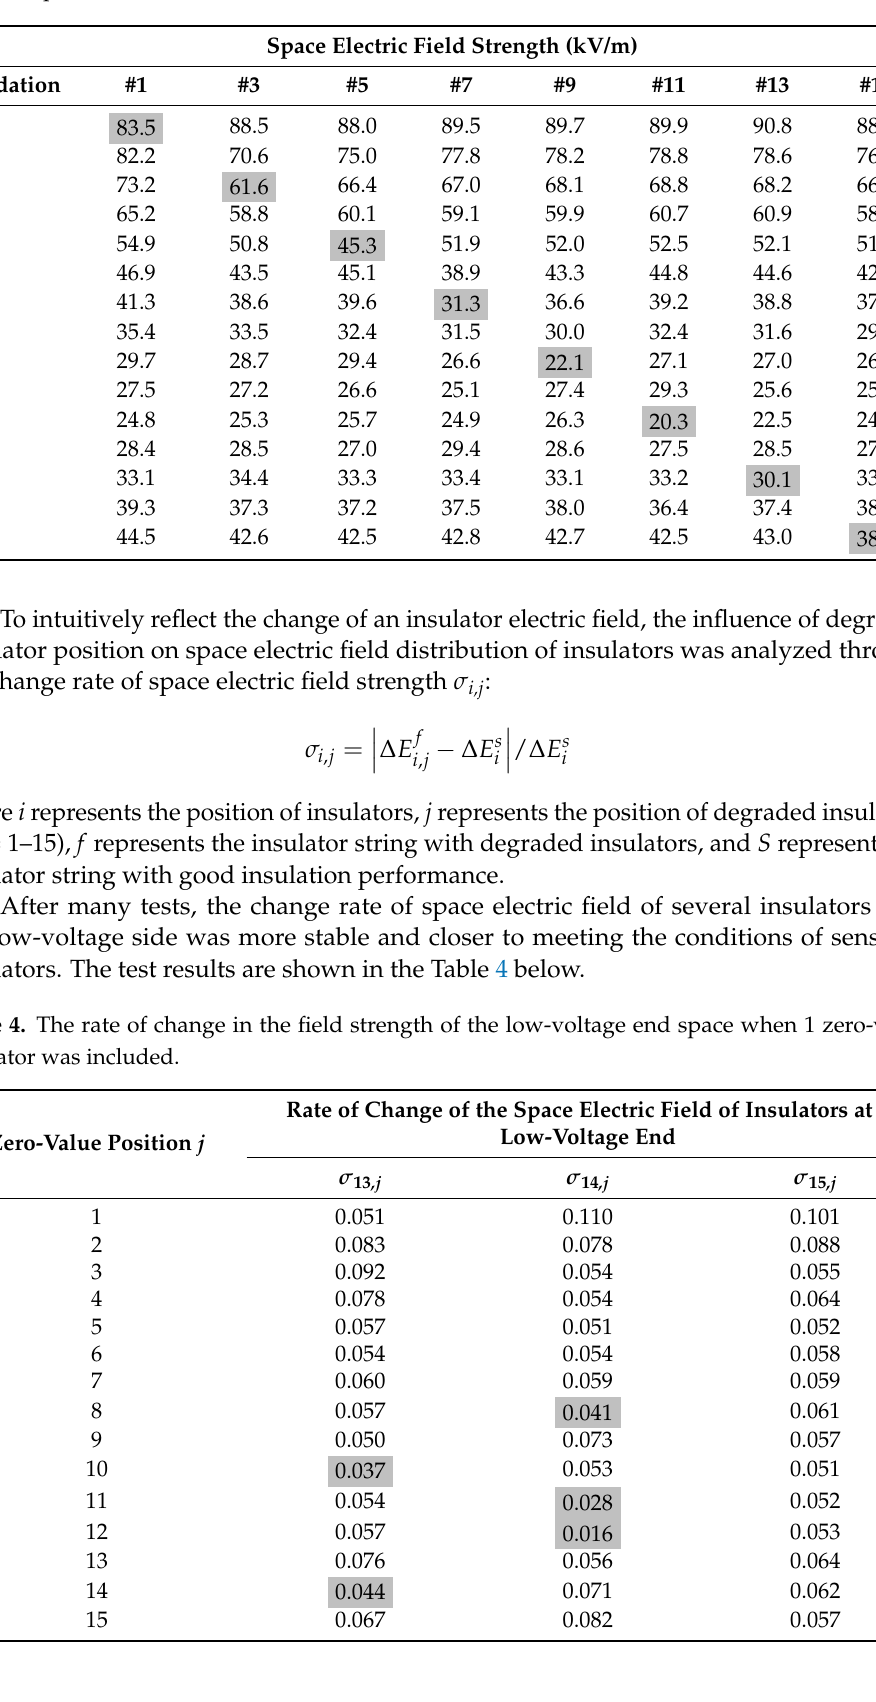
Table 3. Spatial electric field distribution when zero-valued insulators are included.